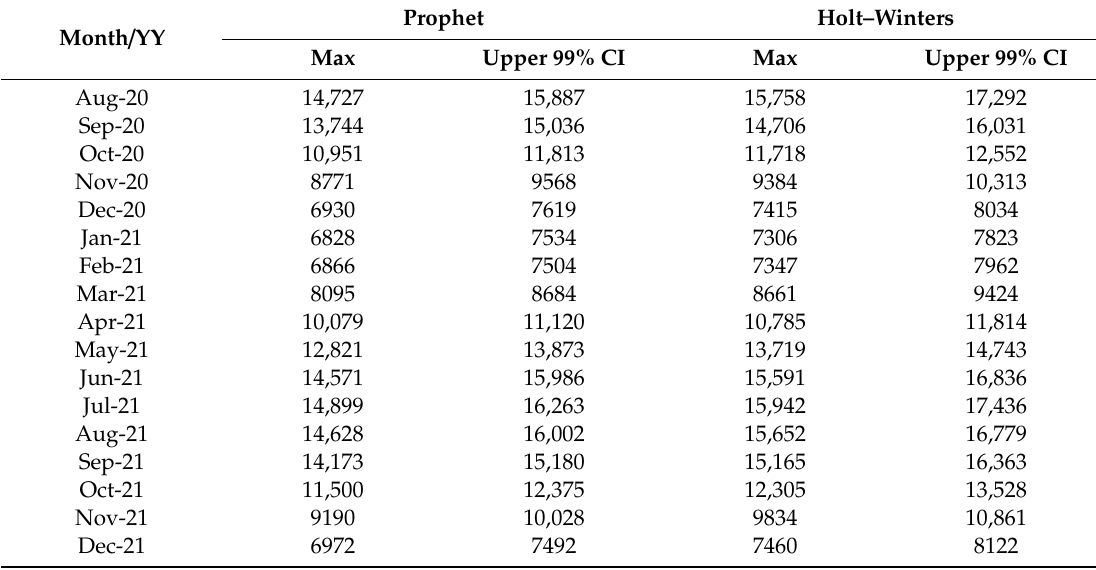
Table 4. Comparison between the monthly maximum load of forecasted maximum peaks from the Prophet and Holt–Winters